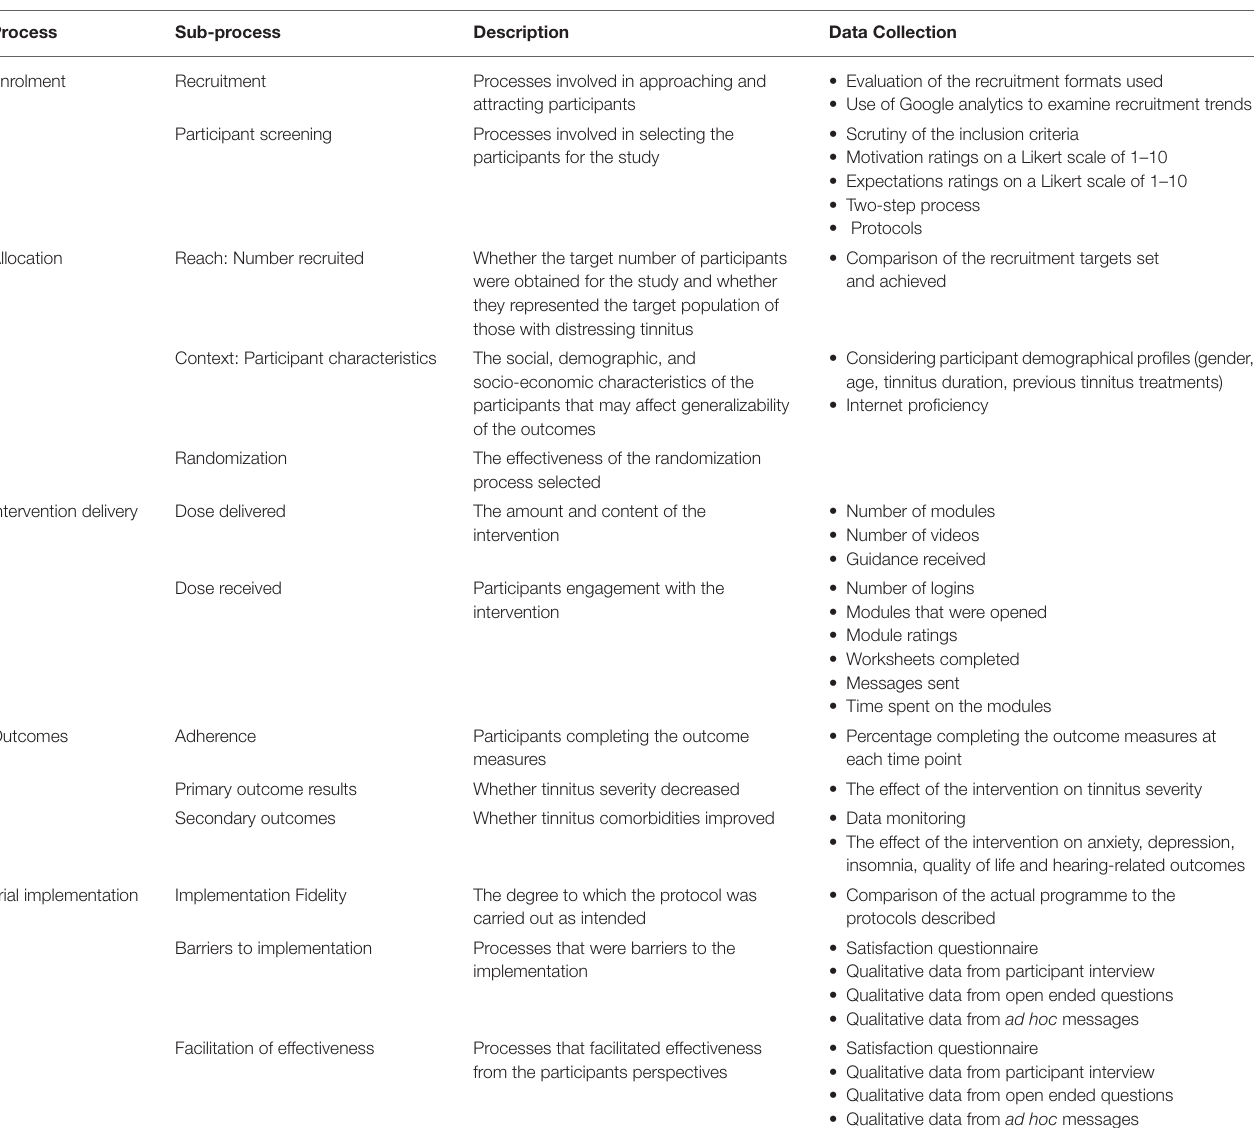
TABLE 1 | The processes in the clinical